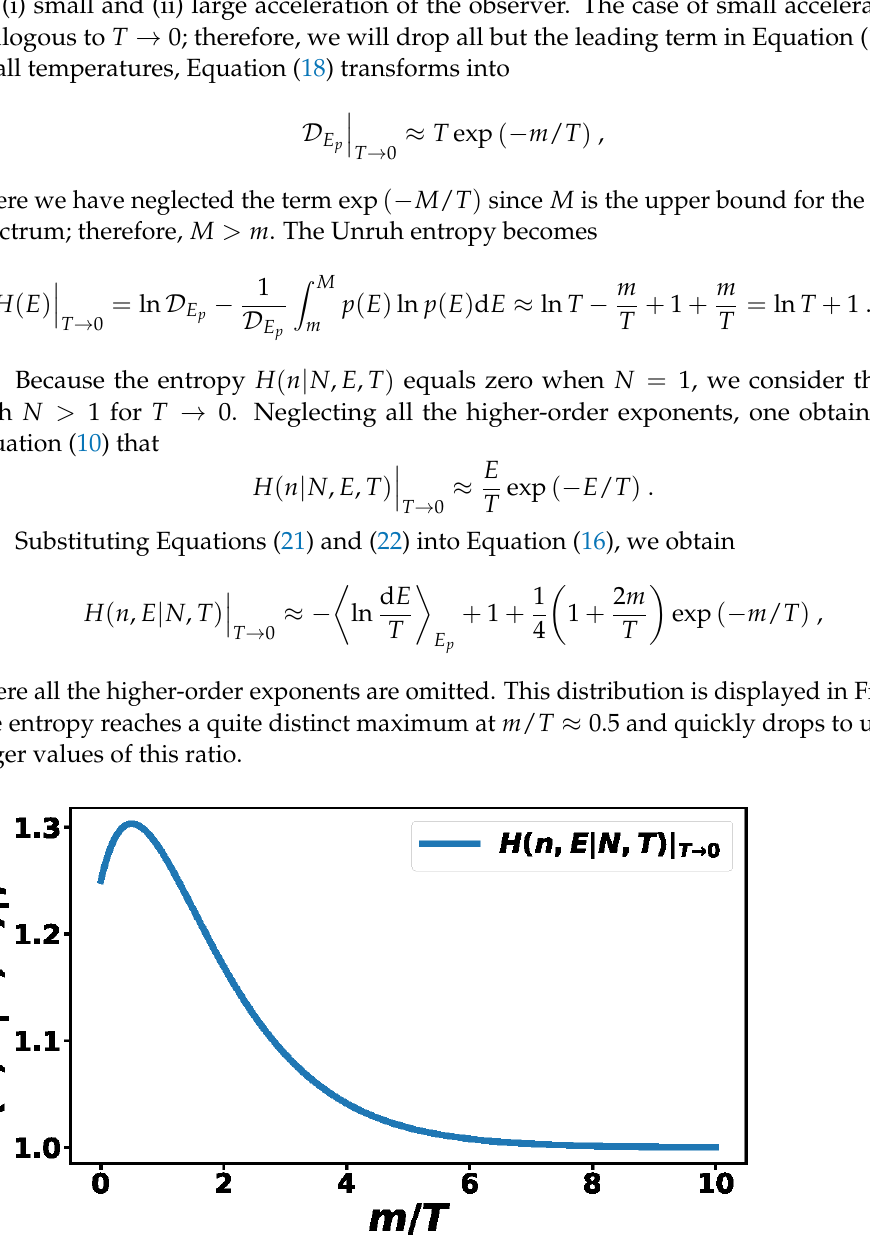
Figure 3. (Color online) Asymptotic behavior of entropy H ( n , E | N , T ) given by Equation (23) at T → 0 as function of m / T